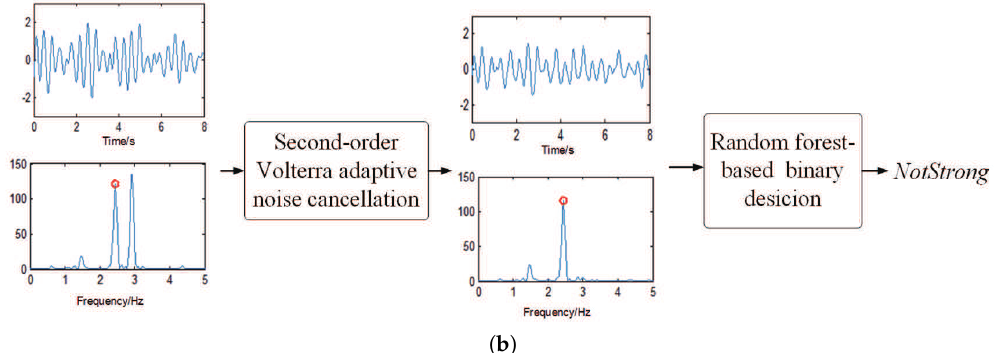
Figure 2. Two examples showing the process of removing MA. In ( a , b ), the waveform in the above layer is in the time domain, and the below layer is the corresponding spectrum. The red cycle in the spectrum represents the spectral peak corresponding to HR, which is obtained by simultaneous ECG. In ( a ), the MA in the denoised signal are determined as Strong , and it shows that a more accurate HR estimation can be obtained by further exploiting singular spectrum analysis (SSA). In example ( b ), the decision result is NotStrong , indicating that SSA should not be used to avoid increasing unnecessary workload. ( b ) shows that the spectral peak of HR still can become dominant by the first MA-removal algorithm without the use of